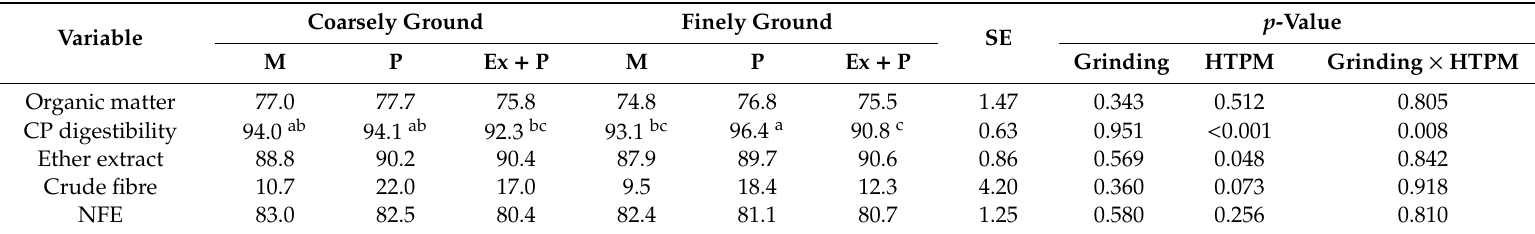
Table 5. Total digestive-tract apparent digestibility [%] of selected crude nutrients according to feeding groups examined in balance trials (LsMeans, n = 6).